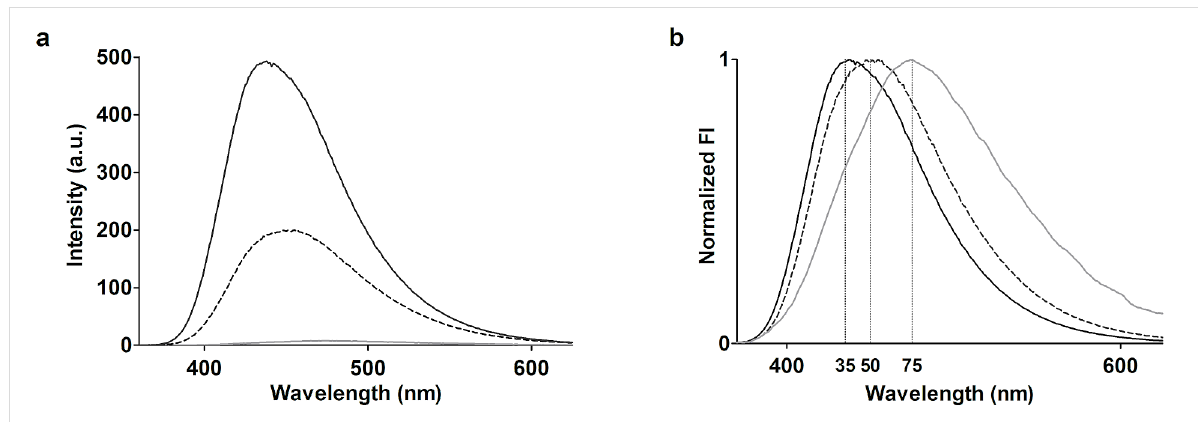
Figure 4: (a) Steady-state fluorescence emission spectra of 50 µM 2,6-ANS in PBS (solid grey, smoothed), in the presence of 4 mM β -CD (black dotted) and in the presence of 2 mM β -CD dimer (plain black) and (b) the corresponding normalized spectra. The emission maxima are in the listed order 475, 450 and 435